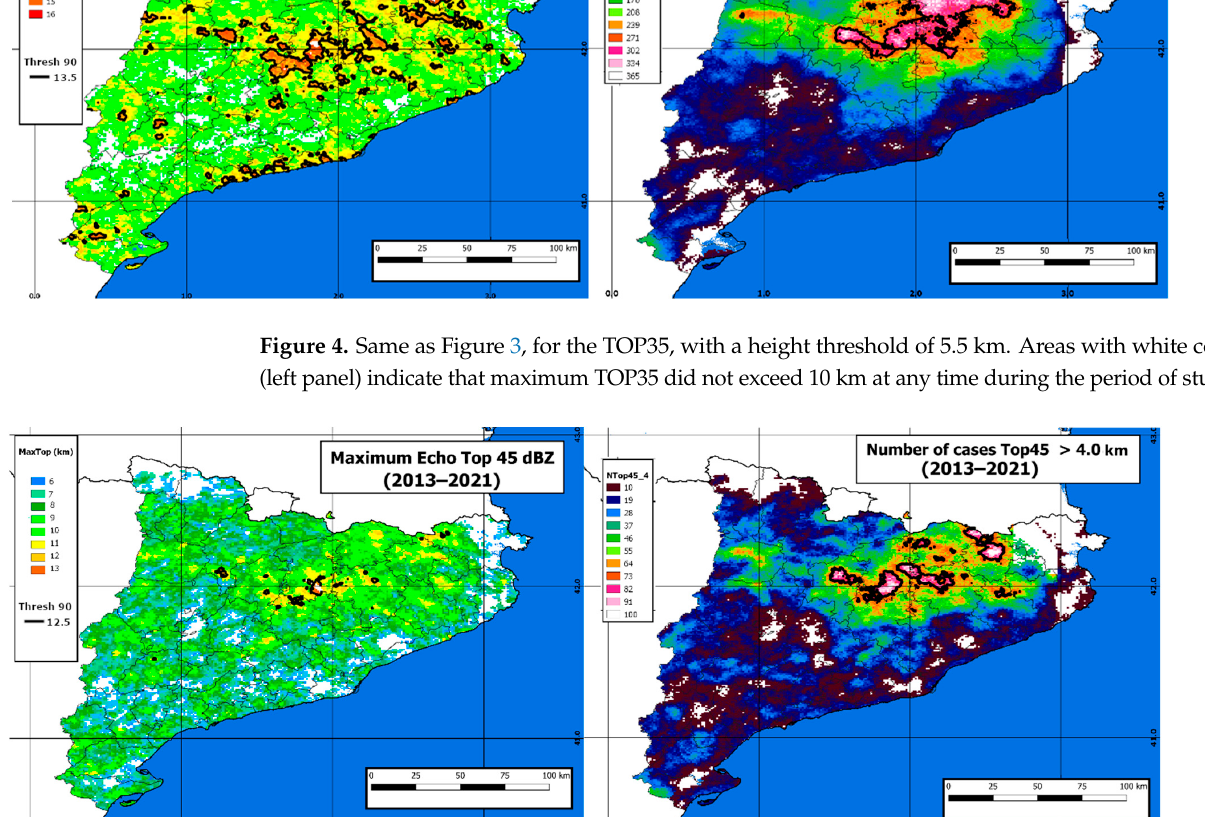
Figure 4. Same as Figure 3, for the TOP35, with a height threshold of 5.5 km. Areas with white color (left panel) indicate that maximum TOP35 did not exceed 10 km at any time during the period of study.